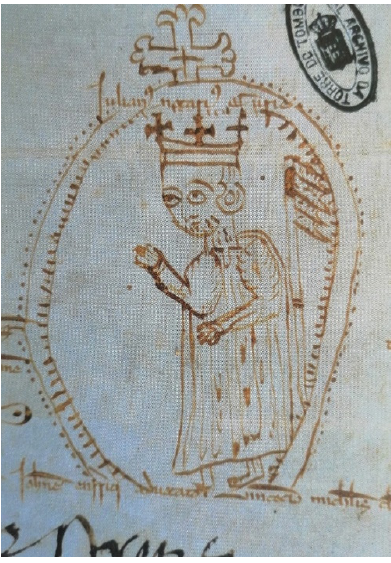
Figure 3. Sancho I. Drawing of the royal seal on a document (ANTT, Gavetas, gav. 15, mç. 10, doc. 14). Second half of the 13th century. Photo: © ANTT